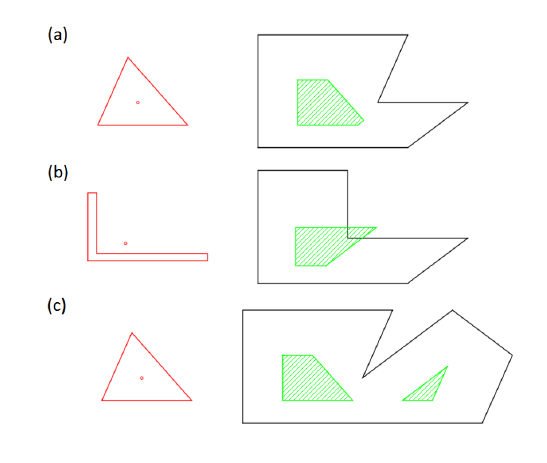
Figure 3: Minkowski substraction (green) between a parcel (black) and a building (red) from building center (red point) for different configurations : standard (a), building strong non- convexity leading center of mass to be located outside polygon (b) and non-connectedness (c) cases.